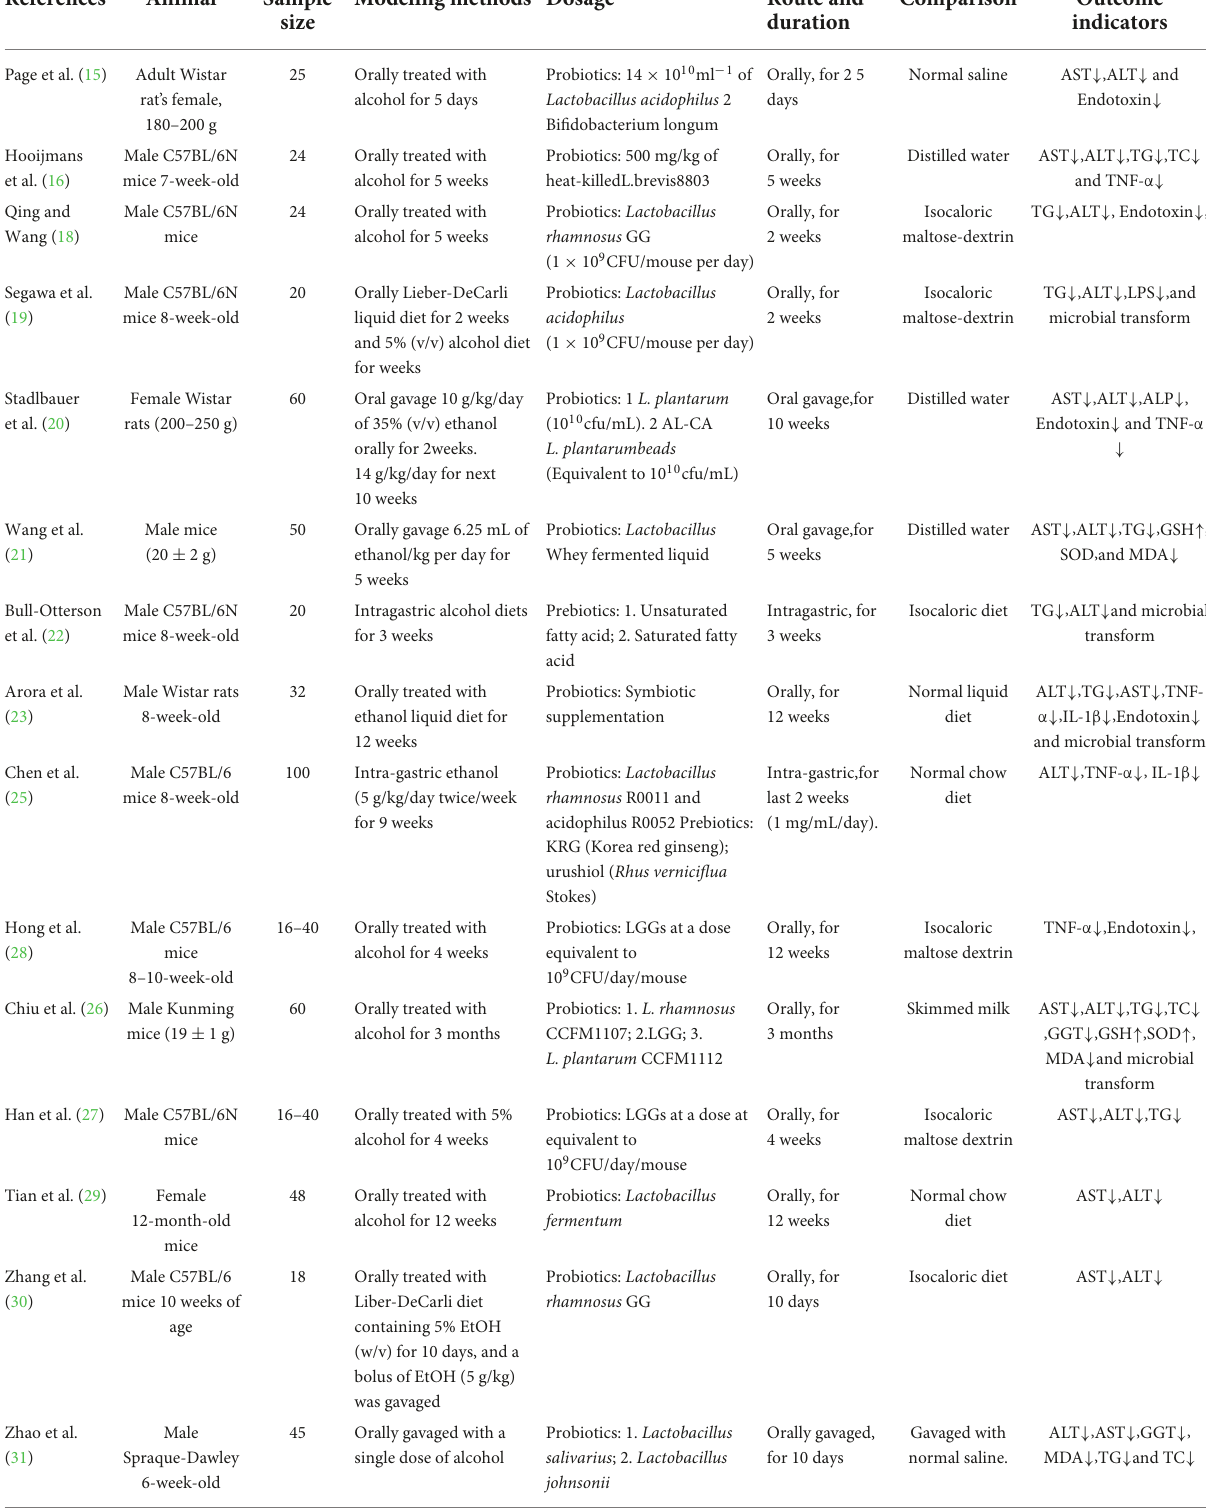
TABLE 1 Characteristics of included studies investigating the effects of probiotics and prebiotics on animal